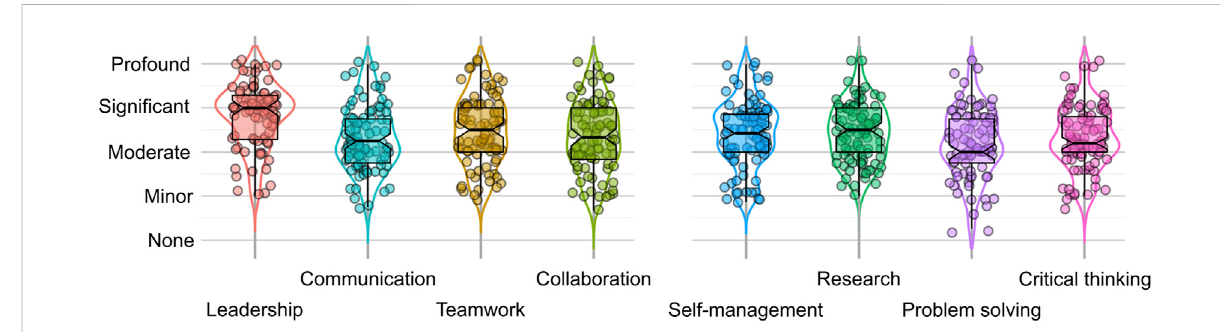
FIGURE 2 Higher-order skills improvement. Participant response distributions for higher-order skill groups. Data points indicate the average respondent rating for each group (see Table 1 for details). Curves represent thedistribution of data points (violinplots), and the notched boxes represent the 2nd and 3rd quartiles of the data (box plots).